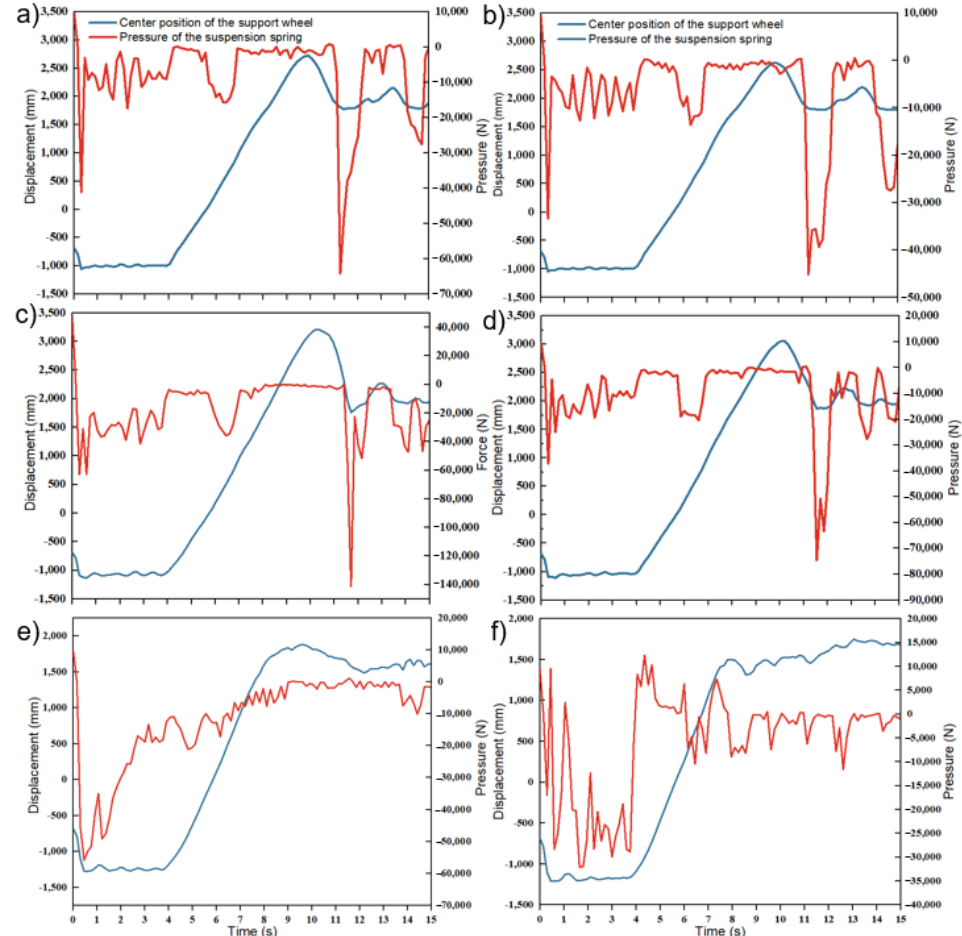
Figure 7. Virtual sample vehicle climbing over obstacles ( a – f ) are the process of vehicle driving).